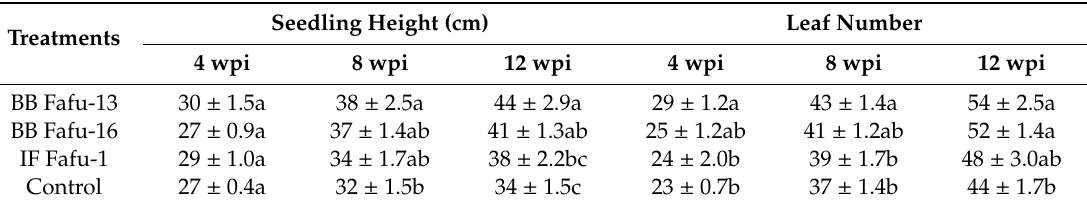
Table 2. Mean ( ± SE) plant growth parameters (height and leaf number) of citrus seedlings at di ff erent weeks post-inoculation (4, 8, and 12) with Beauveria bassiana BB Fafu-13, BB Fafu-16, Isaria fumosorosea IF Fafu-1 and untreated